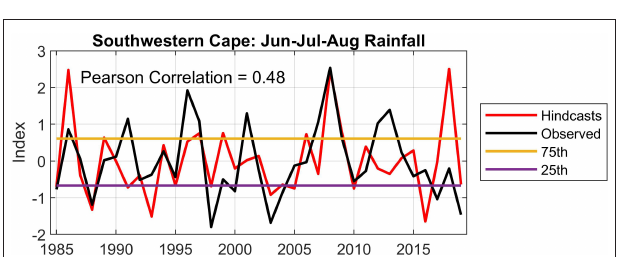
FIGURE 5 | As for Figure 1 , but for Jun-Jul-Aug rainfall at the farm located in the southwestern Cape of South Africa. The correlation value’s level of confidence is at the 99.4%